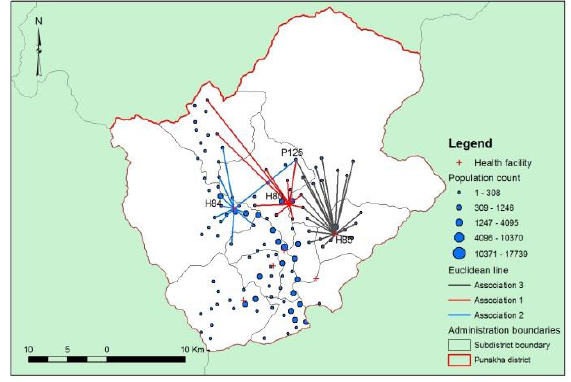
Figure 7: Straight-line distances between population clusters and health facilities